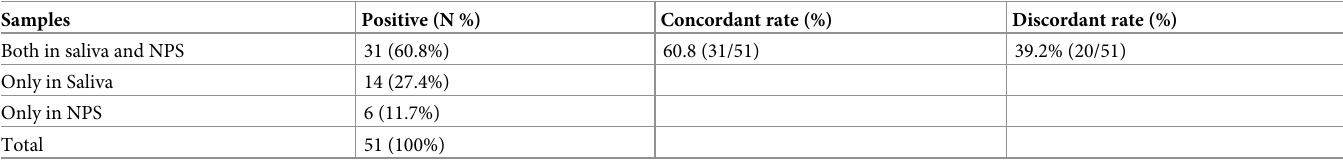
Table 4. Concordant and discordant rate between the saliva and NPS (only positives) for comparative evaluation of saliva and NPS for SARS-CoV-2 detection using RT-PCR among COVID-19 suspected patients at Eastern (n = 51). Samples